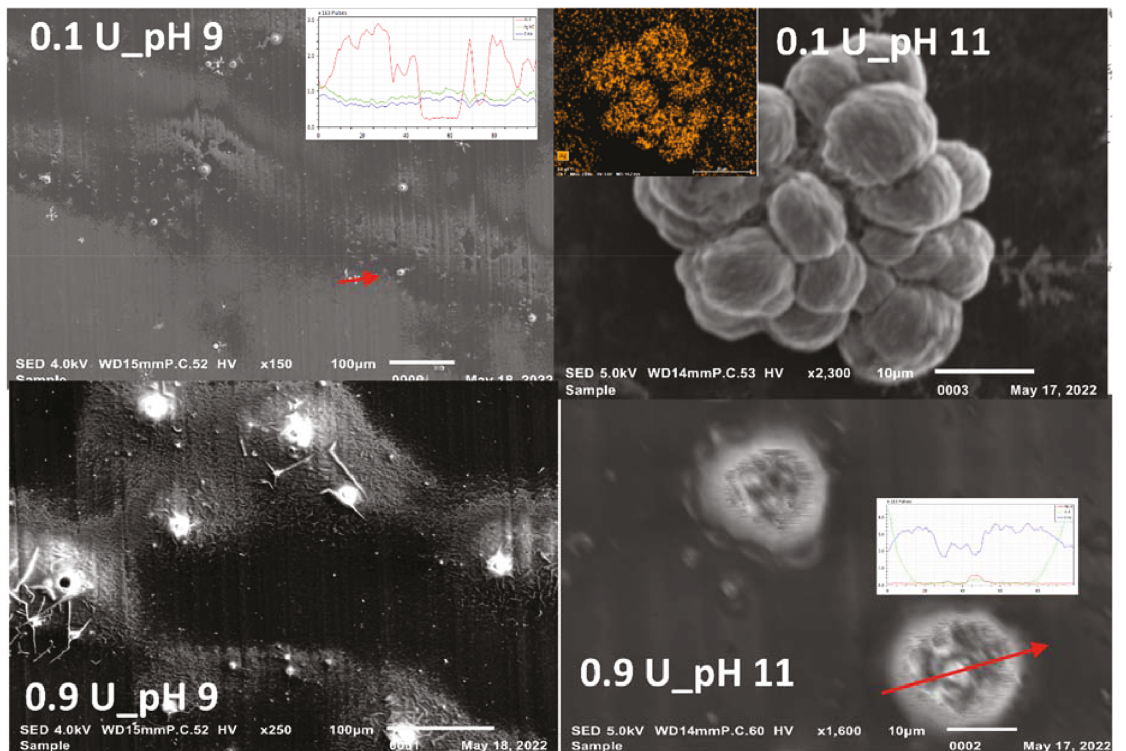
Figure 5: SEM of Ag NPs obtained under 0.1g or 0.9g of U. maydis at pH 9 and pH 11 after 100 seconds of sunlight exposure at room temperature with inserts that demonstrate the formation of Ag NPs, the agglomerations, and the encapsulation of Ag NPs with structures that contain C element related with UM